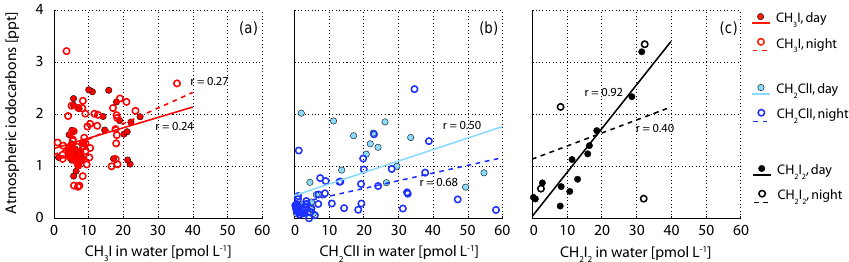
Figure 7. Atmospheric iodocarbons vs. oceanic iodocarbons for CH 3 I (a) , CH 2 ClI (b) and CH 2 I 2 (c) , with the filled and open circles representing data obtained during the daytime and night-time, respectively, including least-squares lines (solid for day, dashed for